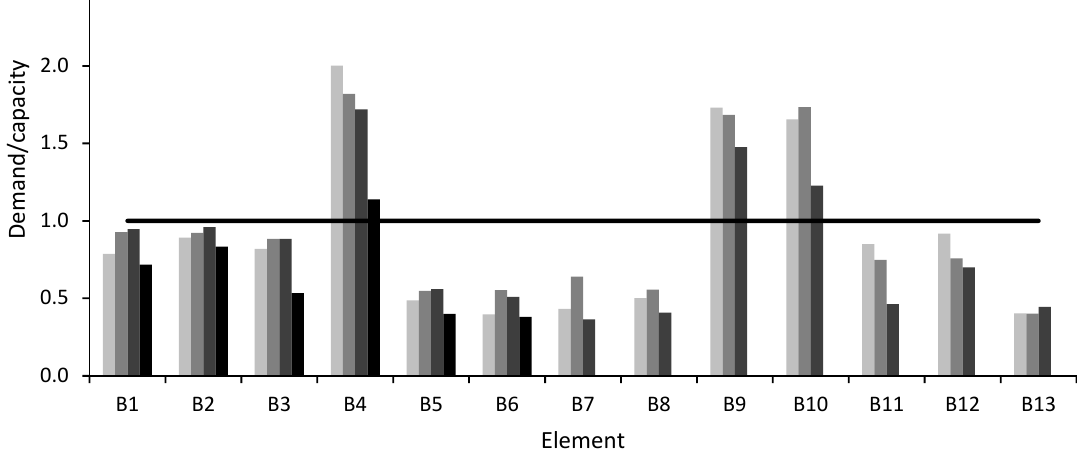
Figure 4. Bending verifications of beams in as-built condition.